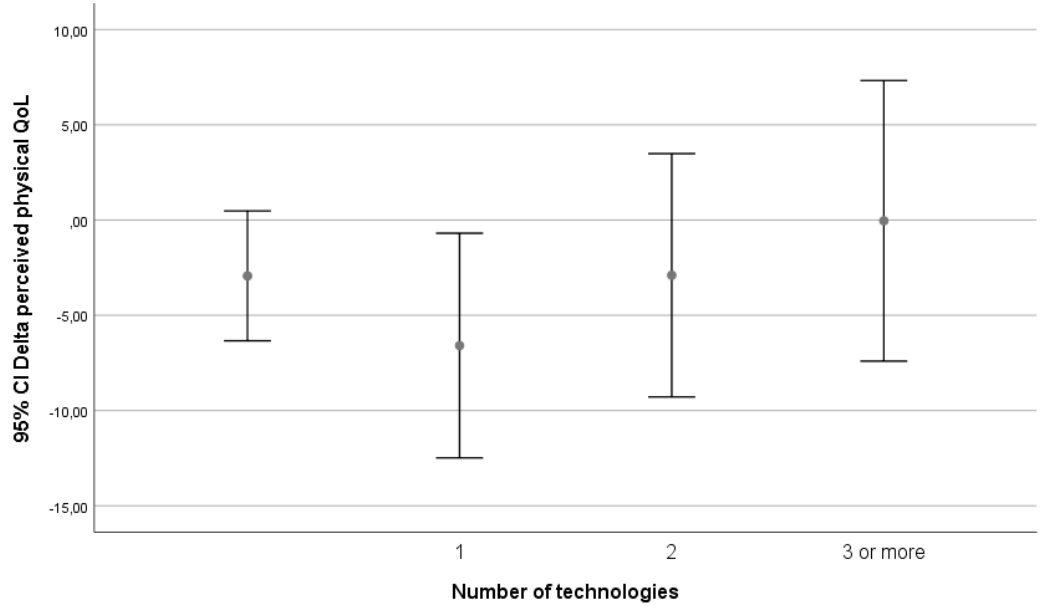
Figure 1. Relation between delta perceived physical health (SF-12 (physical health T12) − SF-12 (physical health T0) ) and number of technologies (1,2 or 3 or more) compared with those who did not get or did not get matched to technology.